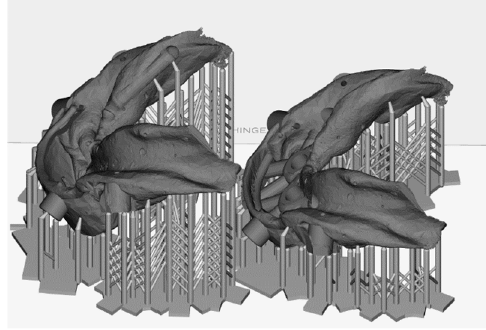
Figure 6. 3D-printing preview of the guides.